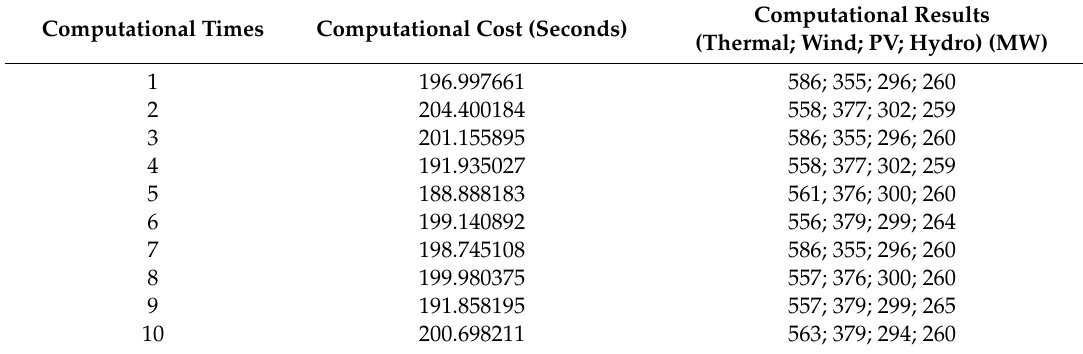
Table A1. Computation cost of MOPSO as a smart contract.